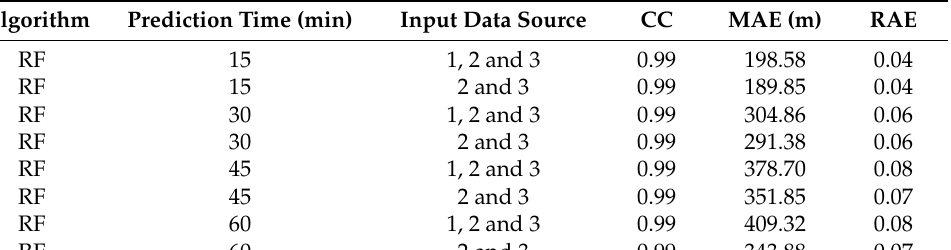
Table 9. Better statistical results of short-term visibility forecast using regressive algorithms and those whose training was performed using the data set with configuration (5), whose records were divided as Auto-WEKA default.